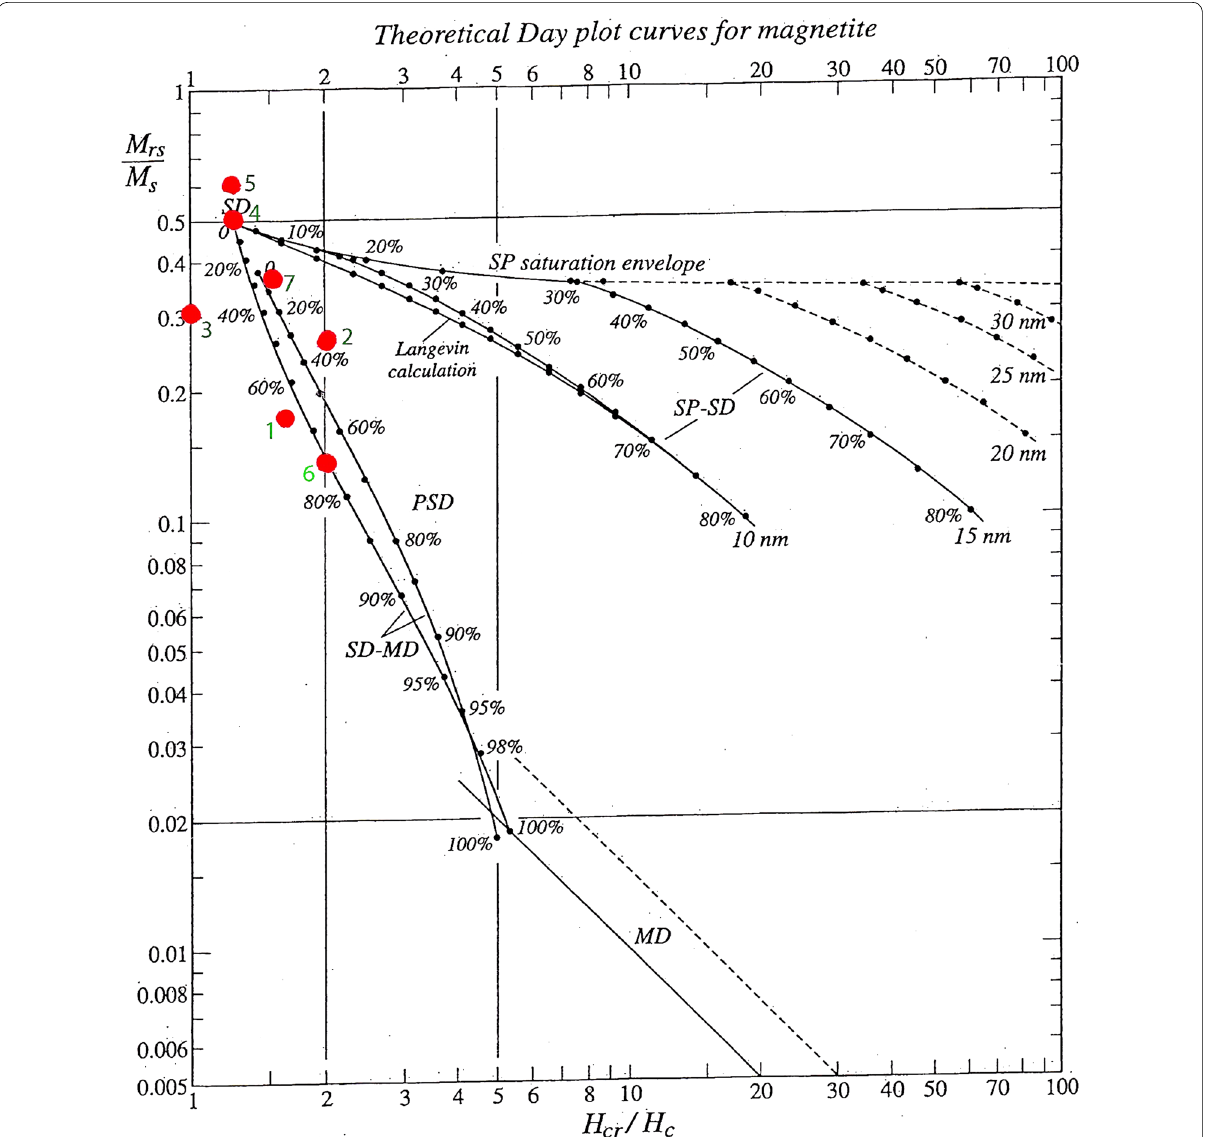
Fig. 5 Results of the hysteresis experiments performed on seven representative samples displayed in a Mrs/Ms versus Hcr/Hc, Day plot with limits between single domain (SD), pseudo‑single domain (PSD) and multi‑domain (MD) grains after Dunlop (2002). The figure also shows mixing curves calculated for magnetite using the equations developed by Dunlop (2002). Numbers along the curves are volume fractions of the soft component (SP or MD) in mixtures with SD grains. The dikes analyzed are DK1; DK2; DK3; DK4; DK5; DK6 and DK7. The plot shows green numbers 1, 2, 3, 4, 5, 6 and 7 corresponding to the seven dikes